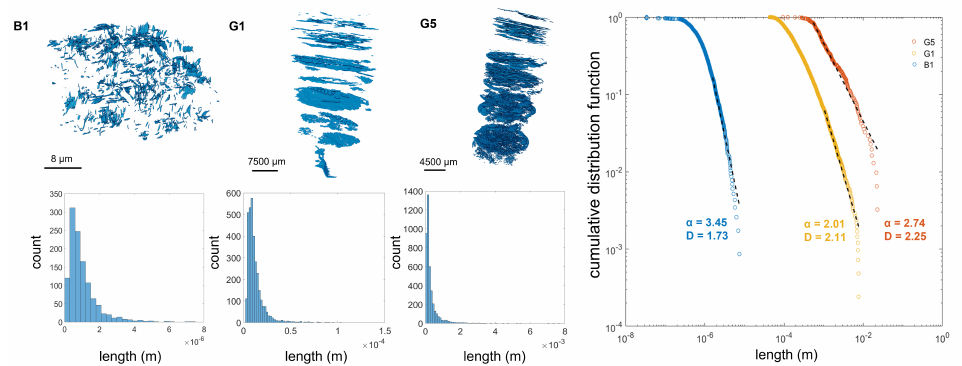
Figure 4. Segmented fracture networks and cumulative distribution function for 3D shale rock images corresponding to samples B1, G1, and G5.